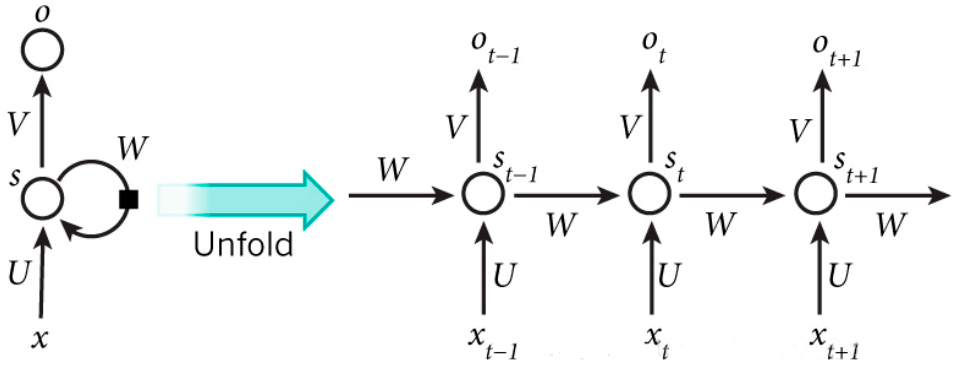
Figure 6. The layer unfolding of the hidden layers of the recurrent neural network (RNN) model. 𝑡 − 1 , 𝑡 , 𝑡 + 1 denote the time series. 𝑥 denotes the input sample, ℎ